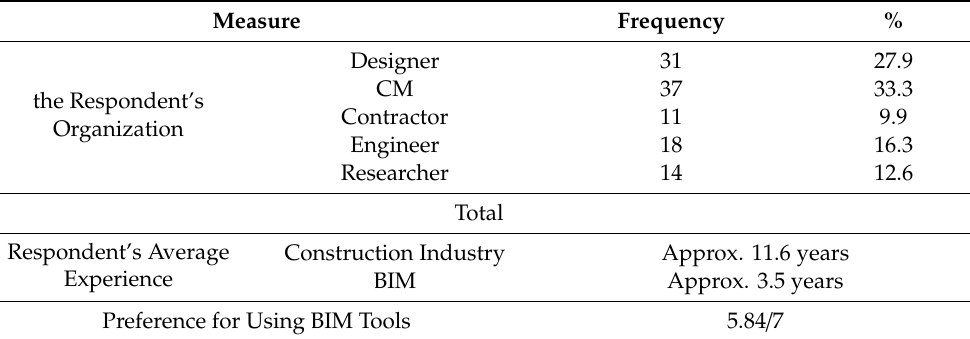
Table 1. Characteristics of the respondents ( n =